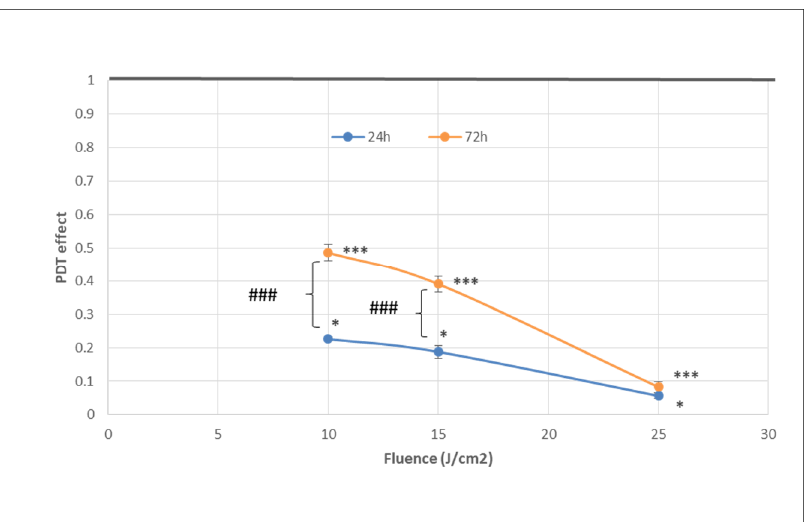
Figure 4. The dependence of MTS reduction by PDT-treated HT29 tumor cells on the fluence of the activation light delivered at a fluence rate of 50 mW/cm 2 . Results are presented as PDT effect (mean ± SEM) in triplicate samples. PDT effect was calculated as OD in PDT-treated samples divided by the mean value of OD in control samples. Comparison between samples was performed using Student’s t -test considering unequal variances: comparison between PDT regimens at a specific time-point: * p < 0.05, *** p < 0.001; comparison between samples at 24 h and 72 h: ### p <